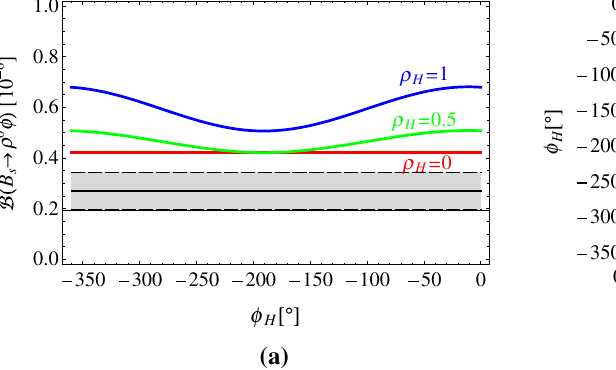
95% C.L. under the constraint from the measured B ( ¯ B s → ρ 0 φ) ; the dashed line corresponds to ρ H = 0 . 5, and the best-fit point corresponds = 0 . to χ 2 min